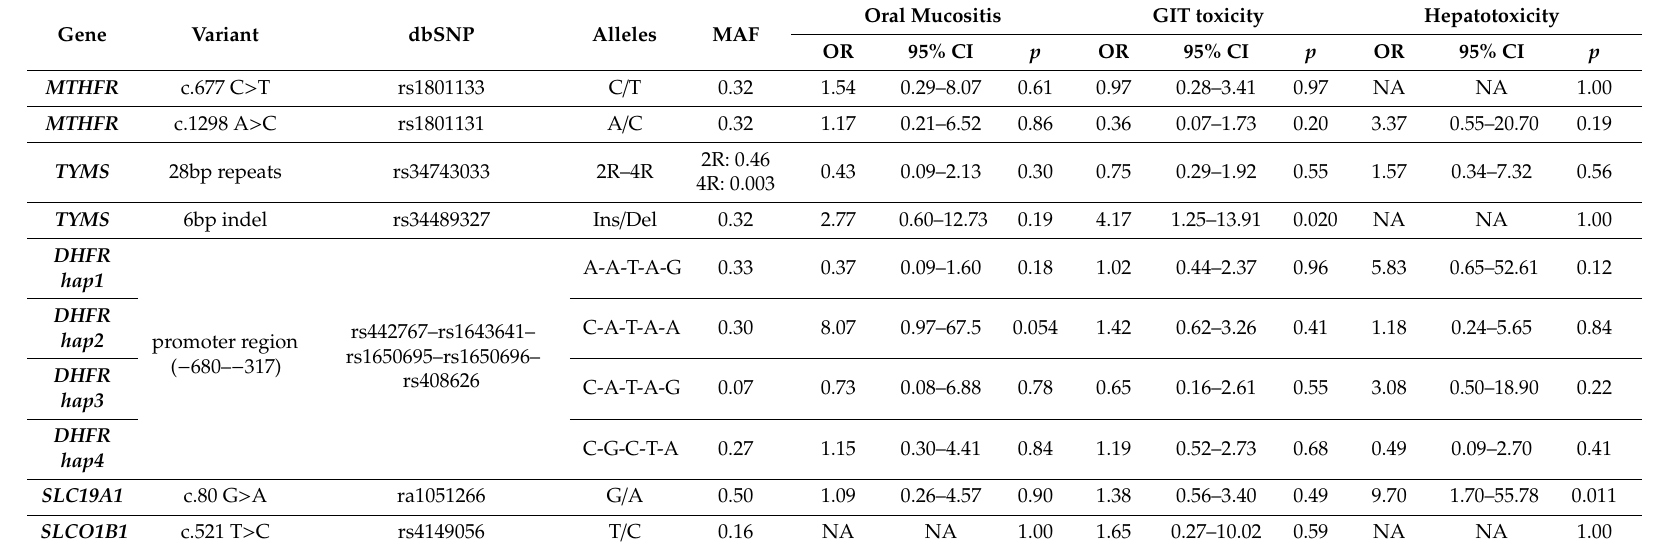
Table 3. Genetic variation in folate pathway genes as predictive markers of GIT toxicity, hepatotoxicity and oral mucositis (Toxicity grade 0-1 versus 2-4). To assess the association of genetic variants with medium to severe toxicity, logistic regression was used, and all probabilities were adjusted for age, gender and MTX dose. The recessive genic model was applied for variants in TYMS , methylenetetrahydrofolate reductase ( MTHFR ), SLC19A1 and SLCO1B1 genes, with the reference group comprising common homozygotes and heterozygotes. Patients with denoted dihydrofolate reductase ( DHFR ) haplotypes were compared against the patients who carried all other haplotypes, the latter group being the reference group for statistical